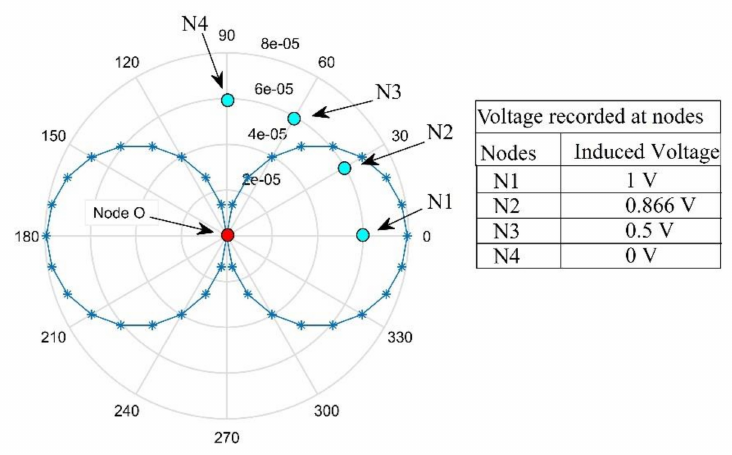
Figure 3. Identification of directionality issue in single-dimensional MI